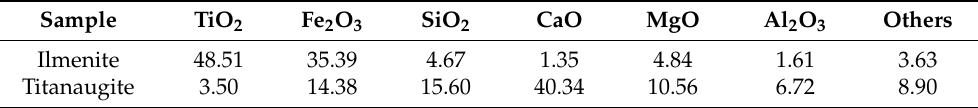
Table 1. Chemical compositions of purified ilmenite and titanaugite samples (mass fraction, %).